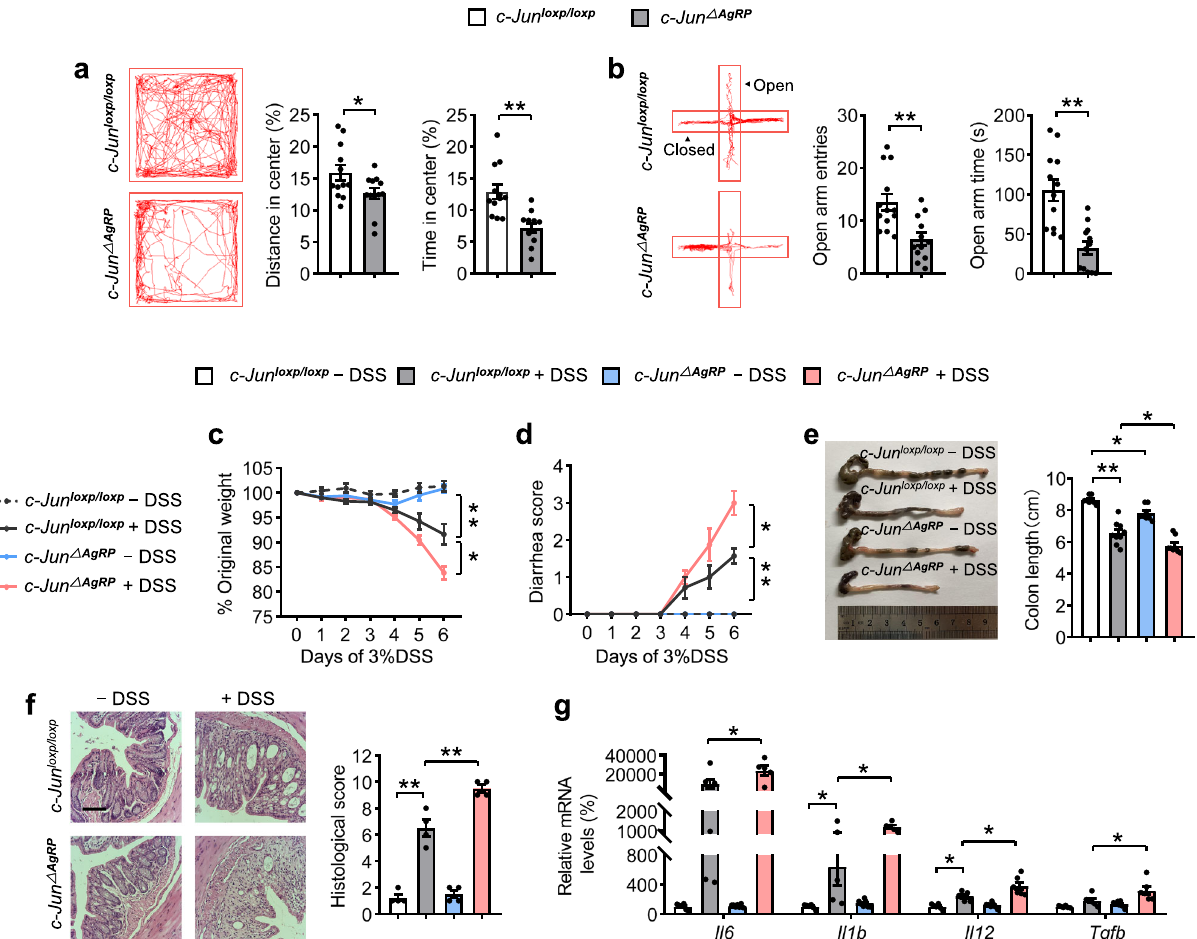
Fig. 3 Deletion of c-Jun in AgRP neurons facilitates anxiety-like behaviors and colitis. a Representative tracks and statistical results in OF test. b Representative tracks and statistics in EPM test. c Percentage of body weight loss. d Scores of diarrhea. e Gross morphology and length of the colon. f H&E staining and histological scores of the colon tissues. Scale bar, 110 μ m. g qRT-PCR analysis of mRNA expression of in fl ammatory cytokines ( Il6, Il1b, Il12 , and Tgfb ) in the distal colonic tissues. Studies for a , b were conducted using 20 – 22-week-old control mice ( c-Jun loxp/loxp ) or mice with c-Jun deletion in AgRP neurons ( c-Jun Δ AgRP ). c – g were performed in c-Jun loxp/loxp and c-Jun Δ AgRP mice administrated with ( + DSS) or without ( − DSS) 3% DSS for 6 days to induce acute colitis. Values are expressed as means ± SEM ( n = 4 – 12 per group), with individual data points. Data were analyzed using two-tailed unpaired Student ’ s t -test ( a , b ). Data were analyzed using two-way analysis of variance, followed by Tukey ’ s multiple comparisons test ( c – g ). * P < 0.05, ** P <